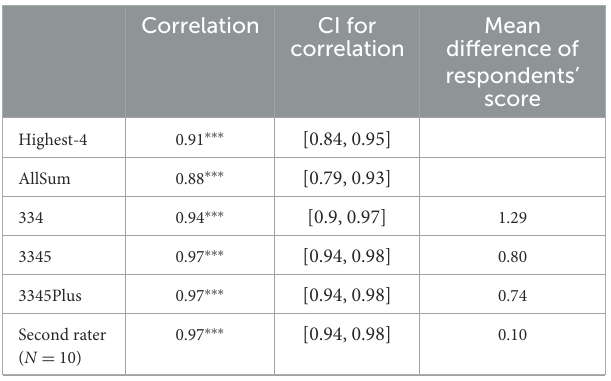
TABLE 5 Correlations with hand scoring ( N =